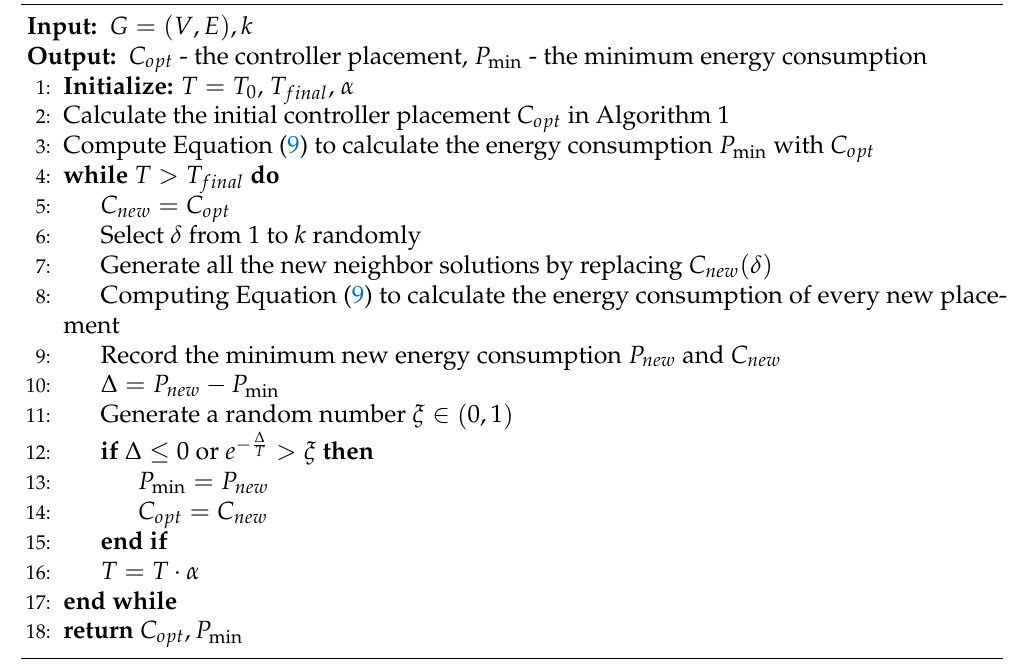
Algorithm 2 Modified Simulated Annealing Placement Algorithm (MSAP).